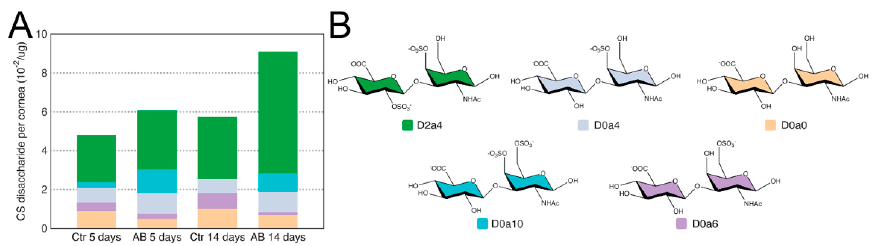
Figure 3. Disaccharide composition of CS/DS in mouse corneas after AB. Total GAGs were extracted from seven pooled corneal tissues and digested with Chondroitinase ABC in order to generate CS and DS disaccharides. These were then separated by strong anion exchange chromatography using a high pressure liquid chromatography system (SAX-HPLC). The eluent was subjected to fluorescent post-column derivatization using 2-cyanoacetamide in the presence of NaOH. The disaccharide separation profiles were compared to the separation of standard disaccharides for identification and quanti- fication, and, the abundance of the different CS/DS disaccharides in the injured and uninjured corneas represented ( A ). Representation of the chemical structure of the CS/DS disaccharides identified in the corneal samples before and after AB ( B ). Table 2. Chondroitin/dermatan sulfate content in corneas of wild-type mice 5 and 14 days after AB.